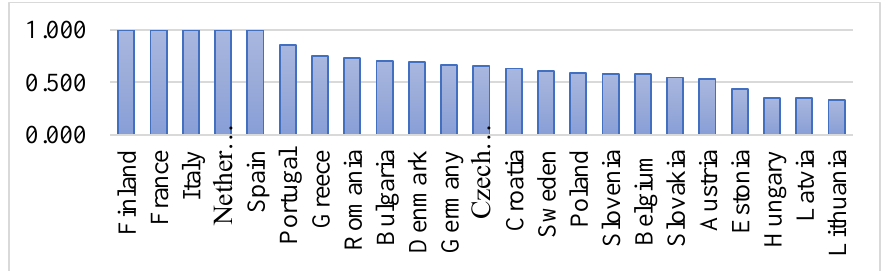
Figure 2. DEA- based efficiency score by country. Source: authors’ projection. Figure 2. DEA-based efficiency score by country. Source: authors’ projection.